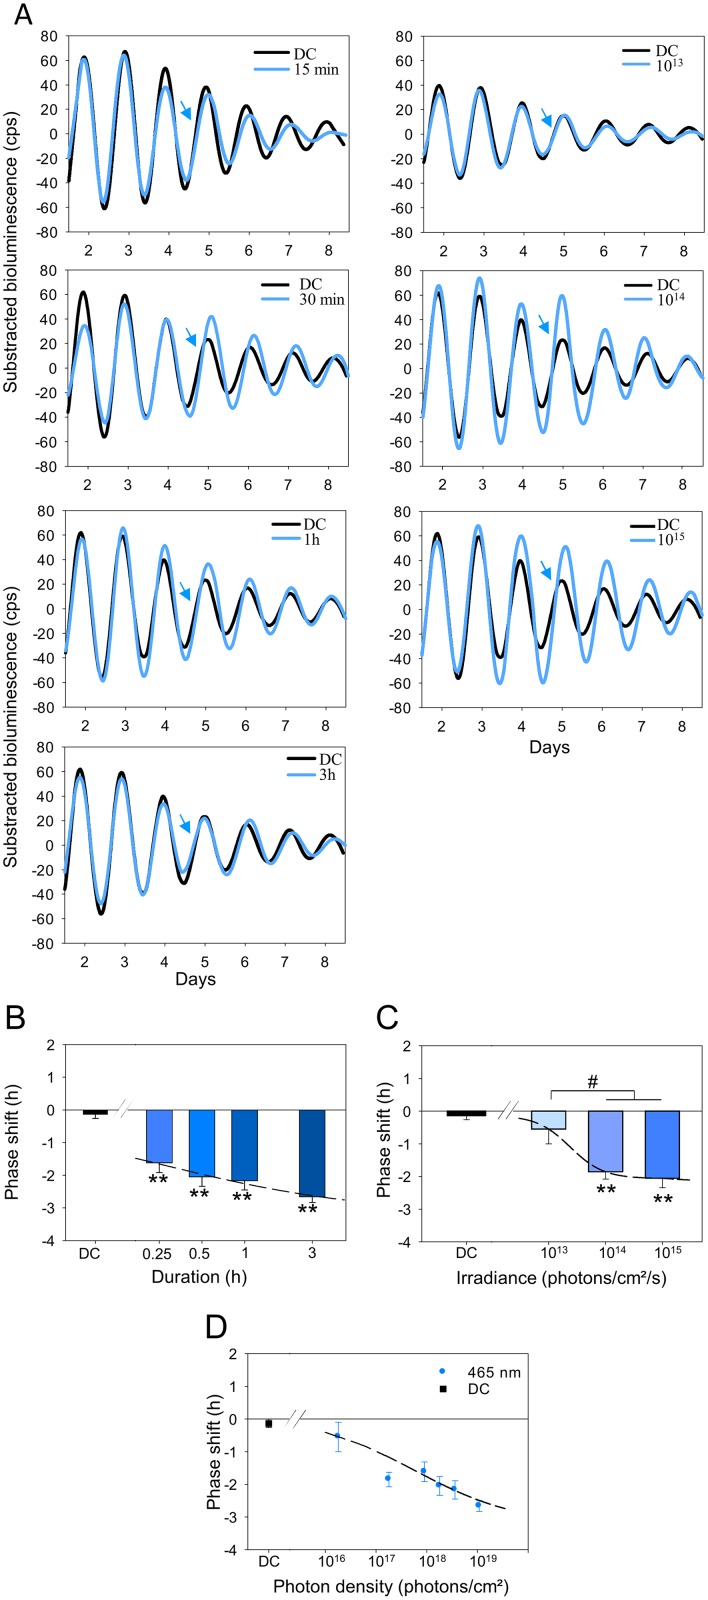
Temporal and irradiance responses for light-induced phase shifts of the retinal clock at 465 nm in the WT Per2Luc mice.A. Representative PER2::Luc bioluminescence traces of retinal explants exposed to different durations (0.25, 0.5, 1, and 3 h; blue lines, left panel) and irradiances (1013, 1014, and 1015 photons/cm2/s; blue lines, right panel) compared to retinas not exposed to light (DC; black lines). The blue arrow indicates the time of the stimulation (CT16). B, C, D. Mean light-induced phase shift after a 465-nm light stimulation at CT16 of different durations with a constant irradiance (1015 photons/cm2/s) (B), at different irradiances with a constant duration (0.5 h) (C), and as a function of total photon density (D). Bars represent mean ± SEM (DC: n = 17; 0.25 h: n = 4; 0.5–3 h: n = 6–7; 1013–1015 photons/cm2/s: n = 5–7). *Represents statistically significant differences with the DC and #statistical differences between different light conditions. **P < 0.001, #P < 0.01. The data used to make this figure can be found in S1 Data. CT, circadian time; DC, dark control; PER2::Luc, PERIOD2::Luciferase; WT, wild-type.